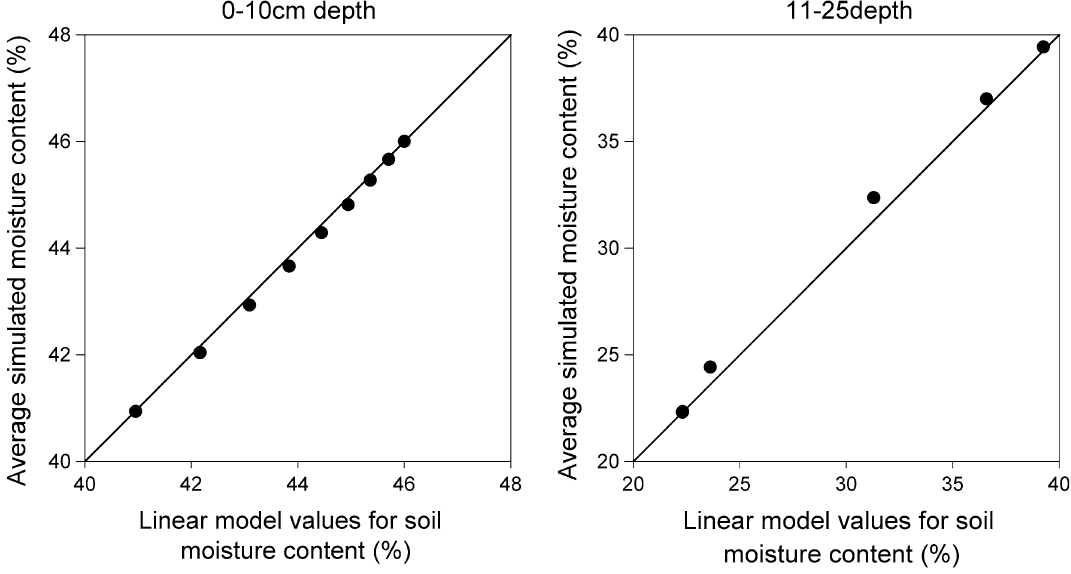
Fig. 2 Model simulation values were compared with either the average saturated water conductivity or the linearly varying saturated water con- ductivity as a